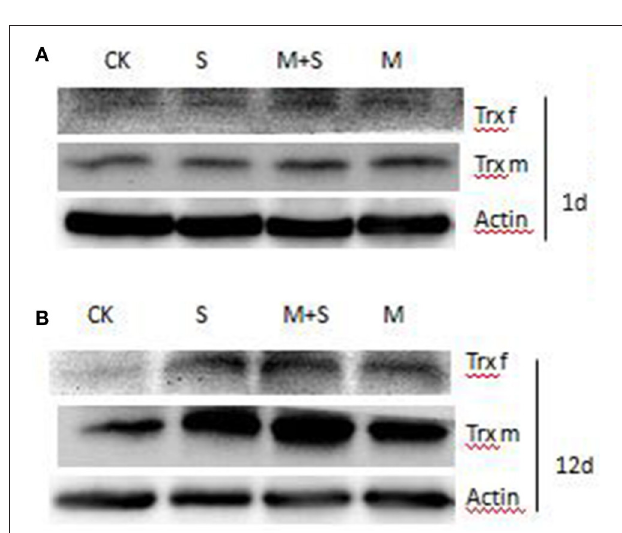
FIGURE 6 | Immunoblot analyses of TRX f and TRX m in tomato leaves. Leaf extracts from different treatments after 1 day and after 12 days. Total proteins was analyzed using antibodies raised against pea TRX f and pea TRX m. Immunoblotting of actin (ACT, 45 kDa bottom) served as loading controls. CK, control; M, 150 µ M melatonin; S, 150 mM NaCl; M + S, 150 µ M melatonin with 150 mM